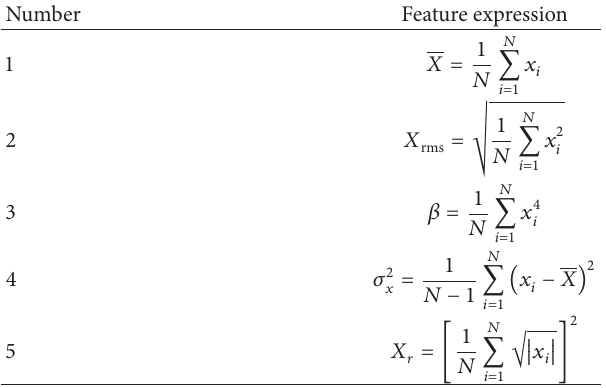
Table 1: The dimensionless time domain characteristic